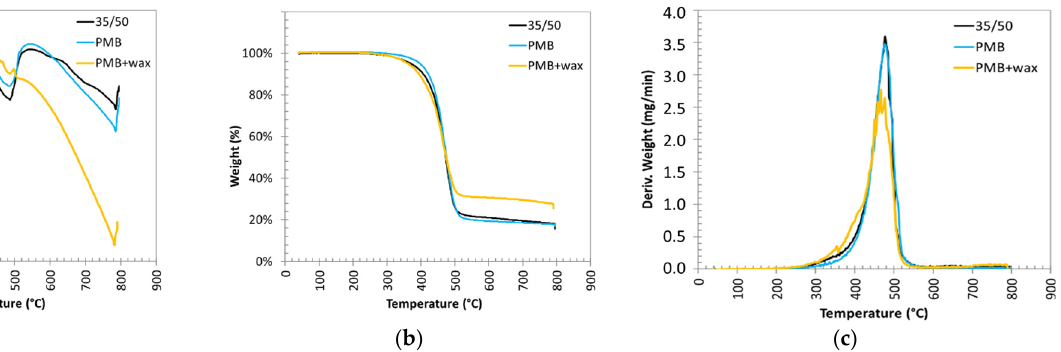
Figure 5. Binders—thermogravimetric analysis (normalized results): ( a ) heat flow; ( b ) weight; ( c ) derivative weight.